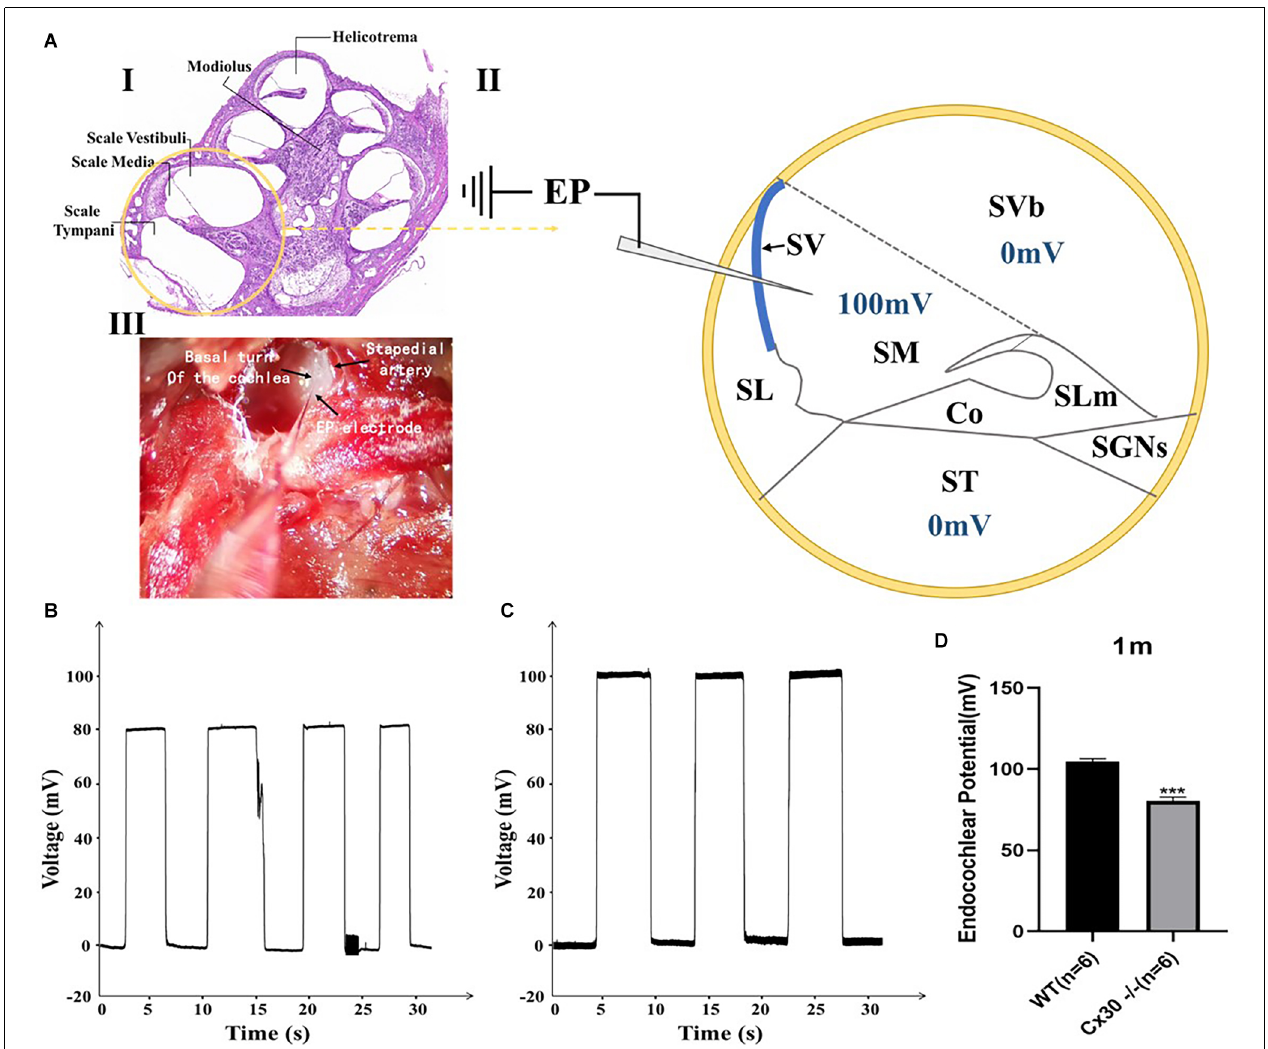
FIGURE 6 | Endocochlear potential (EP) measurements in WT and Cx30 KO mice. (A) (I) Cross-section of a cochlea. (II) Schematic diagram of the cross-section of the basal cochlear turn illustrating the method of EP measurement. A microelectrode filled with 3 M KCl was inserted into the endolymph-filled scala media (100 mV in a WT mouse) to record EP. (III) Photograph of a surgically exposed cochlea before EP measurement showing the location of the stapedial artery and the insertion site of the microelectrode. (B,C) Representative EP recordings from 1-month-old WT and Cx30 KO mice. The traces showed the voltage (mV) of the scala media as a function of time (s). (D) The graph illustrates a significant 23.4% reduction in the EP in 1-month-old Cx30 KO mice (80.1 ± 2.6 mV) compared with age-matched WT mice (104.6 ± 1.9 mV). Data presented as Mean ± SEM ( n = 6). t -test. *** p < 0.001. Co, Corti’s organ; SGNs, spinal ganglion neurons; SL, spiral ligament;